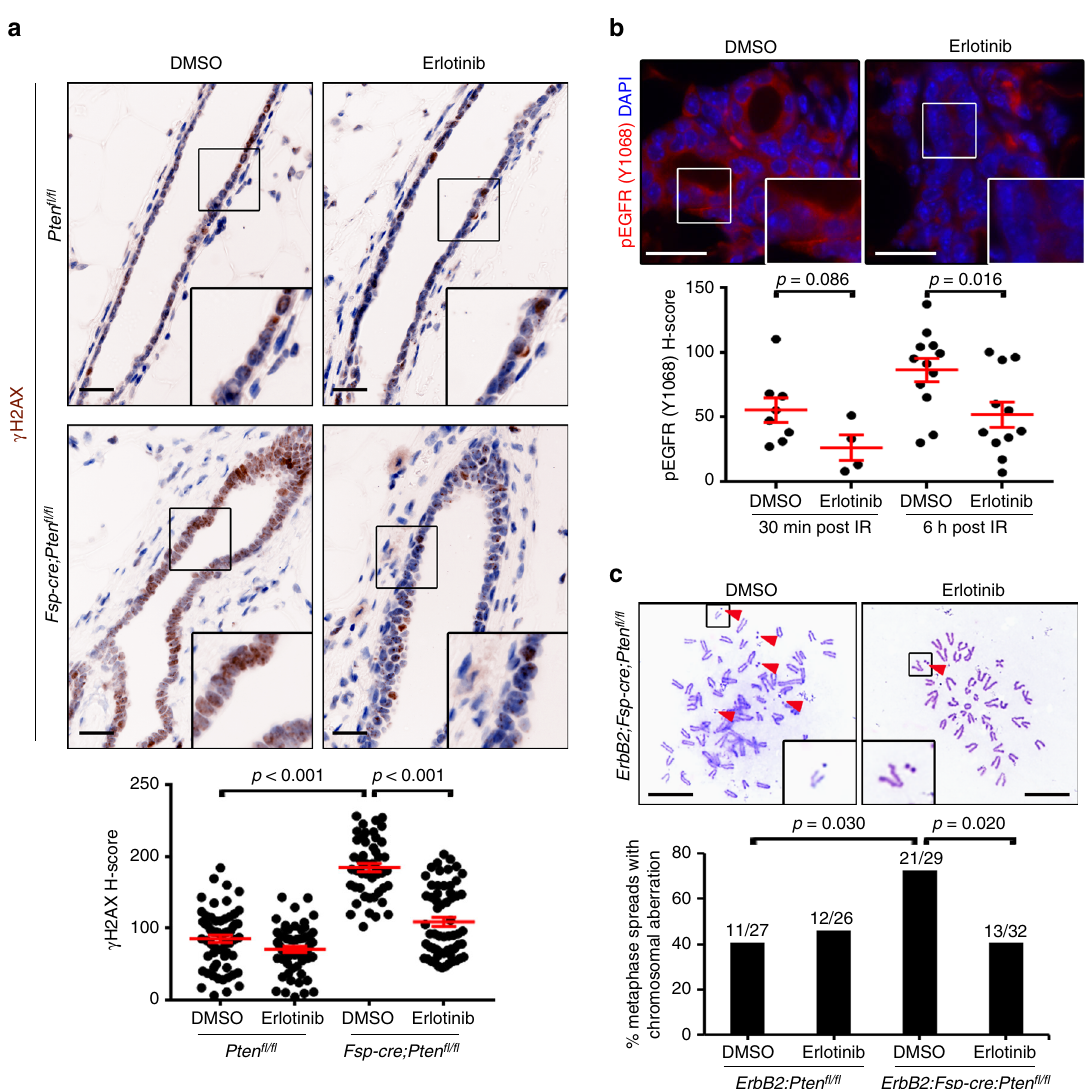
Fig. 4 EGFR inhibition abrogates radiation-induced double-strand DNA breaks and genomic instability in stromal PTEN-null associated epithelium. a Representative γ -H2AX immunohistochemistry and quanti fi cation (mean ± s.e.m.) of mammary epithelium in Pten fl / fl and Fsp-cre;Pten fl / fl mice pre-treated with DMSO or erlotinib, irradiated (6 Gy whole-body) and evaluated 6 h post-radiation. DMSO ( Pten fl / fl ) v. DMSO ( Fsp-cre;Pten fl / fl ) p value determined by unpaired, two-tailed Student ’ s t test. Fsp-cre;Pten fl / fl DMSO v. erlotinib p value determined by two-tailed Mann-Whitney ( Pten fl / fl : DMSO n = 60 fi elds/6 mice, erlotinib n = 60 fi elds/6 mice; Fsp-cre;Pten fl / fl : DMSO n = 48 fi elds/4 mice, erlotinib n = 60 fi elds/6 mice). Scale bar = 20 μ m. b Representative phospho-EGFR (Y1068) immuno fl uorescence and quanti fi cation (mean ± s.e.m.) of mammary epithelium in Pten fl / fl mice pre-treated with DMSO or erlotinib, irradiated (6 Gy whole-body) and evaluated 30 min or 6 h post-radiation (images are 6 h post IR). Both p values determined by unpaired, two- tailed Student ’ s t test (30 min: DMSO n = 8 fi elds/2 mice, erlotinib n = 4 fi elds/1 mouse; 6 h: DMSO n = 12 fi elds/3 mice, erlotinib n = 11 fi elds/3 mice). Scale bar = 20 μ m. c Representative metaphase spreads and quanti fi cation of chromosomal aberrations in epithelial cells of ErbB2;Pten fl / fl and ErbB2;Fsp-cre; Pten fl / fl mice pre-treated with DMSO or erlotinib, irradiated (6 Gy whole-body) and evaluated 1 week post-radiation in vitro. Arrowheads = chromosome break. Both p values determined by two-tailed Fisher ’ s exact test ( ErbB2;Pten fl / fl : DMSO n = 27 spreads/2 mice, erlotinib n = 26 spreads/3 mice; ErbB2;Fsp- cre;Pten fl / fl : DMSO n = 29 spreads/3 mice, erlotinib n = 32 spreads/3 mice). Scale bar = 10 μ